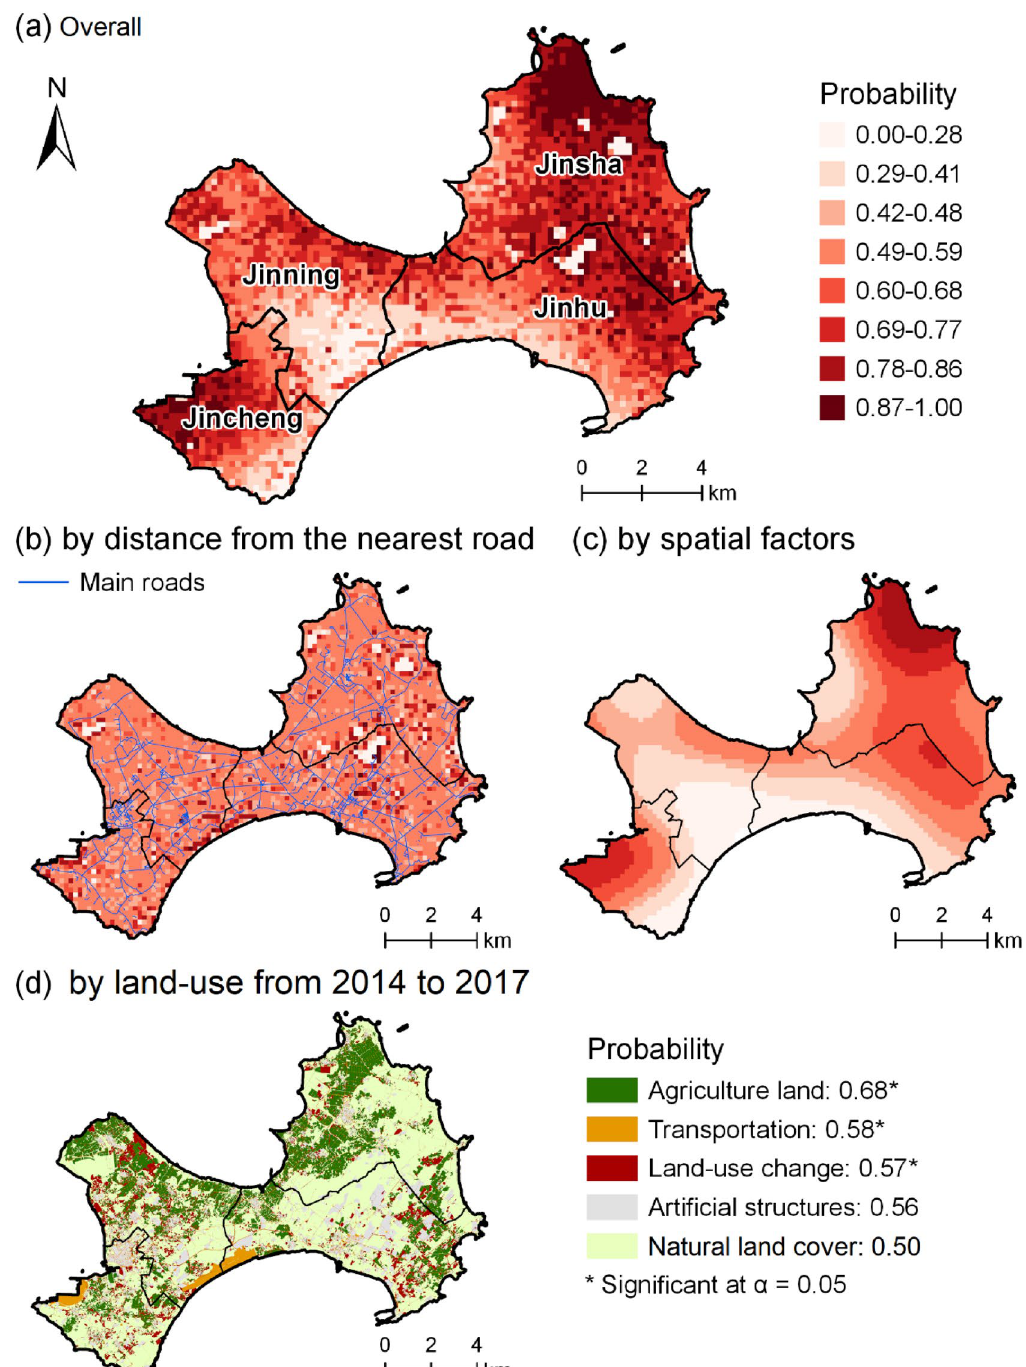
Figure 8. Risks of RIFA successful invasion or remaining at the highest level of invasion (RIFA SIRH) in Kinmen, 2018–2019, into ( a ) overall, ( b ) distance to nearest road, ( c ) spatial autocorrelation, and ( d ) land-use change from 2014 to 2017. This map is generated by ArcGIS 10.7 19